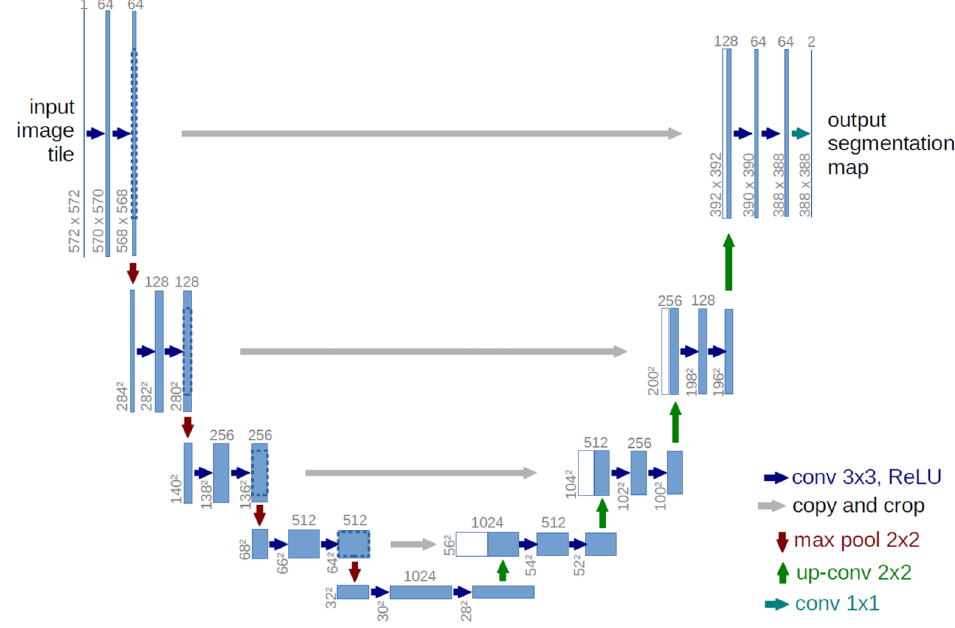
Figure 30. The basic architecture of the U-Net